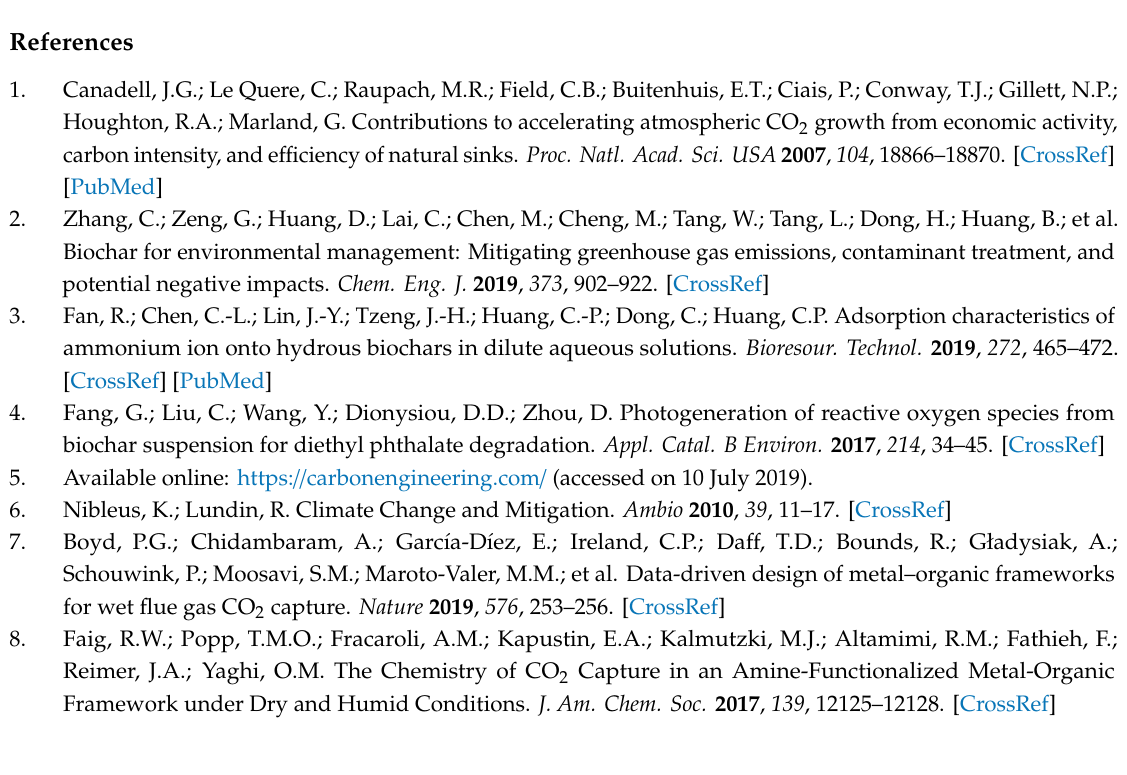
Figure S1: Models of N 2 , O 2 and CO 2 , Figure S2: Back propagation neural network, Figure S3: Decision tree, Figure S4: Random forest, Figure S5: Support vector machine, Figure S6: Di ff usion coe ffi cient D i versus (a) LCD, (b–d) Q st ( D i : the di ff usion coe ffi cient of di ff erent gases, (a,b) CO 2 , (c) N 2 , (d) O 2 ), Figure S7: Henry coe ffi cient K CO2 versus (a) φ , (b) PLD, (c) Q st and (d) VSA, Figure S8: Henry coe ffi cient K N2 versus (a) φ , (b) PLD, (c) Q st and (d) VSA, Figure S9: Henry coe ffi cient K O2 versus (a) φ , (b) PLD, (c) Q st and (d) VSA, Figure S10: Di ff usion selectivity S di ff (CO2 / (N2 + O2)) versus (a) LCD, (b) φ , (c) PLD and (d) VSA, Figure S11: Adsorption selectivity S ads (CO2 / N2 + O2) versus (a) LCD, (b) φ , (c) PLD and (d) VSA, Figure S11: The training results of four machine learning predicted versus MC simulated log 10 ( S ads (CO2 / N2 + O2) ) using density, void fraction, volumetric surface area, density, LCD, PLD and heat of adsorption. (a) BPNN, (b) RF, (c) DT and (d) SVM. The color of point represents the number of MOF, and the unit of mumber is a base-10 logarithm of MOF numbers, Table S1: Lennard-Jones parameters of MOFs, Table S2: Lennard-Jones parameters and charges of adsorbates, Table S3: The training and testing R values of adsorption selectivity using repeat 5 time-four ML. Table S4 Prediction using RF models with di ff erent descriptor combinations. Table S5 Prediction using repeat 5 times-RF models with di ff erent descriptor combinations. Table S6 The results of predicted RF with k times k -fold cross validation. Table S7: Predicted by the RF the relative importance of the six descriptors for adsorption selectivity. Formula S1: S ads (CO2 / N2 + O2) indicates the adsorption selectivity of CO 2 / N 2 + O 2 ; K i represents the Henry coe ffi cient of component i (CO 2 , N 2 and O 2 ), Formula S2: S di ff (CO2 / (N2 + O2)) represents the di ff usion selectivity of CO 2 / N 2 + O 2 ; D i represents the di ff usion coe ffi cient of component i